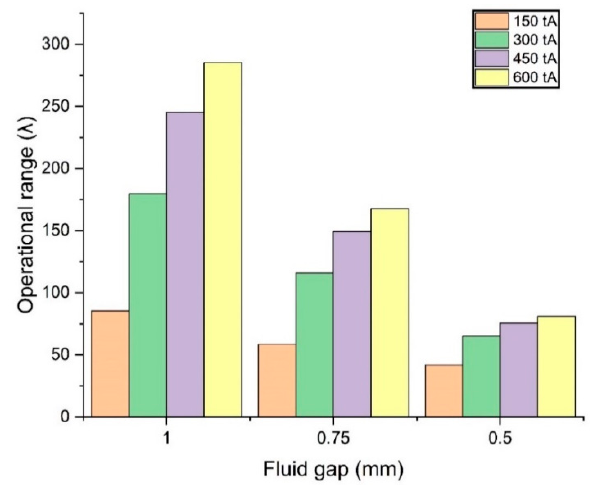
Figure 16. Fluid gap and turn-ampere relationship to operation range.